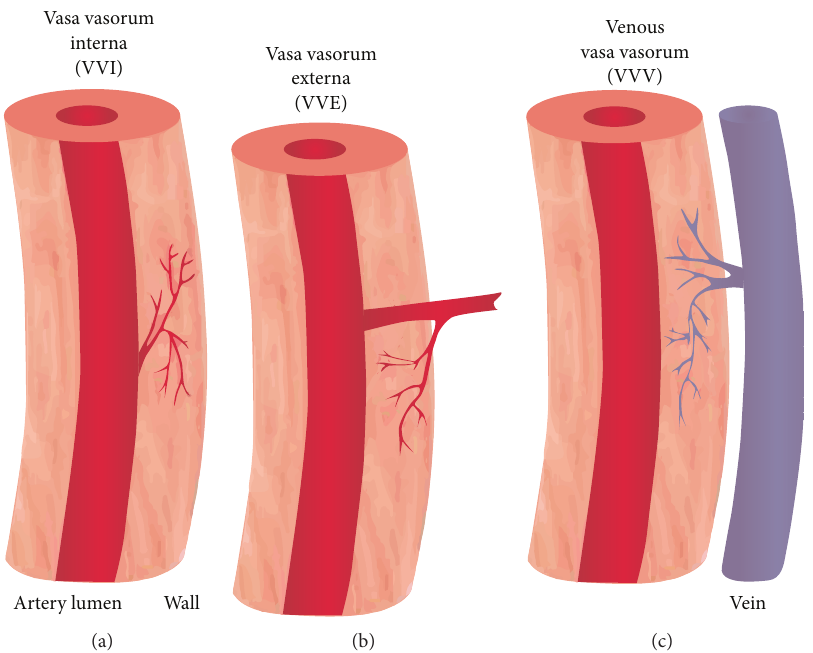
Figure 1: Sketches of the three types of vasa vasorum found in the wall of cow aortae (inspired by Schoenenberger and Mueller [24]). In the Schoenenberger and Mueller study, VVI (a) originated directly from the aorta’s main lumen, and VVE (b) originated from intercostal branches deriving from the main lumen and dived back into the aortic wall. VVV (c) developed in the aortic wall and finally drained into branches of concomitant veins (reprint with permission from